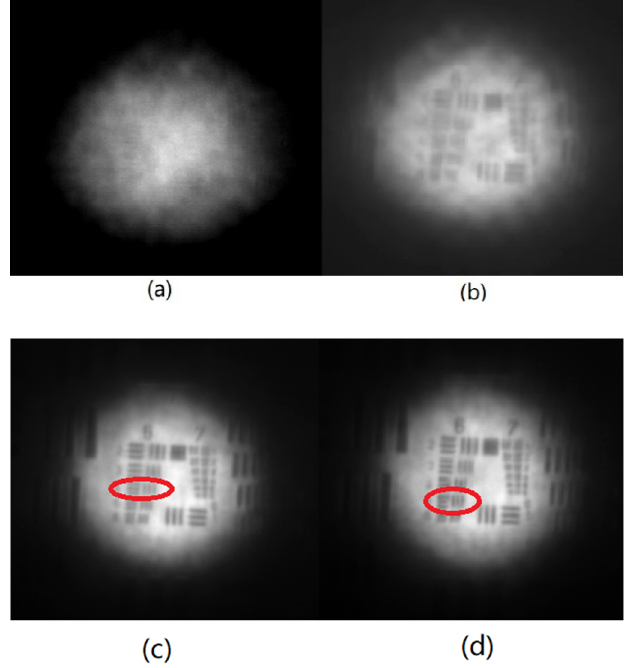
Figure 9. Image captured with the visible camera at 700–950 nm: ( a ) original image without correction; ( b ) image before correction using the LC and after correction through the DM ; ( c ) image after nondecoupling correction with the LC and D M; ( d ) image after decoupling correction through the LC and DM. (The clearest line pair has been circled in red).